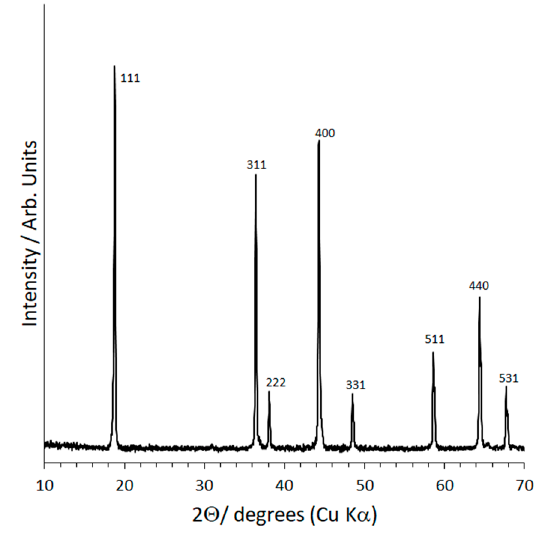
Figure 7. XRD pattern of 0.3 [Li 1.25 Cr 0.25 Mn 1.5 O 4 ]: 0.7 [LiNi 0.5 Mn 1.5 O 4 ] solid solution formed at 850 °C (nominal composition: Li 1.025 Cr 0.025 Ni 0.45 Mn 1.5 O 4 ). XRD peaks are indexed to the Fd 3 m spinel struc ‐ ture.